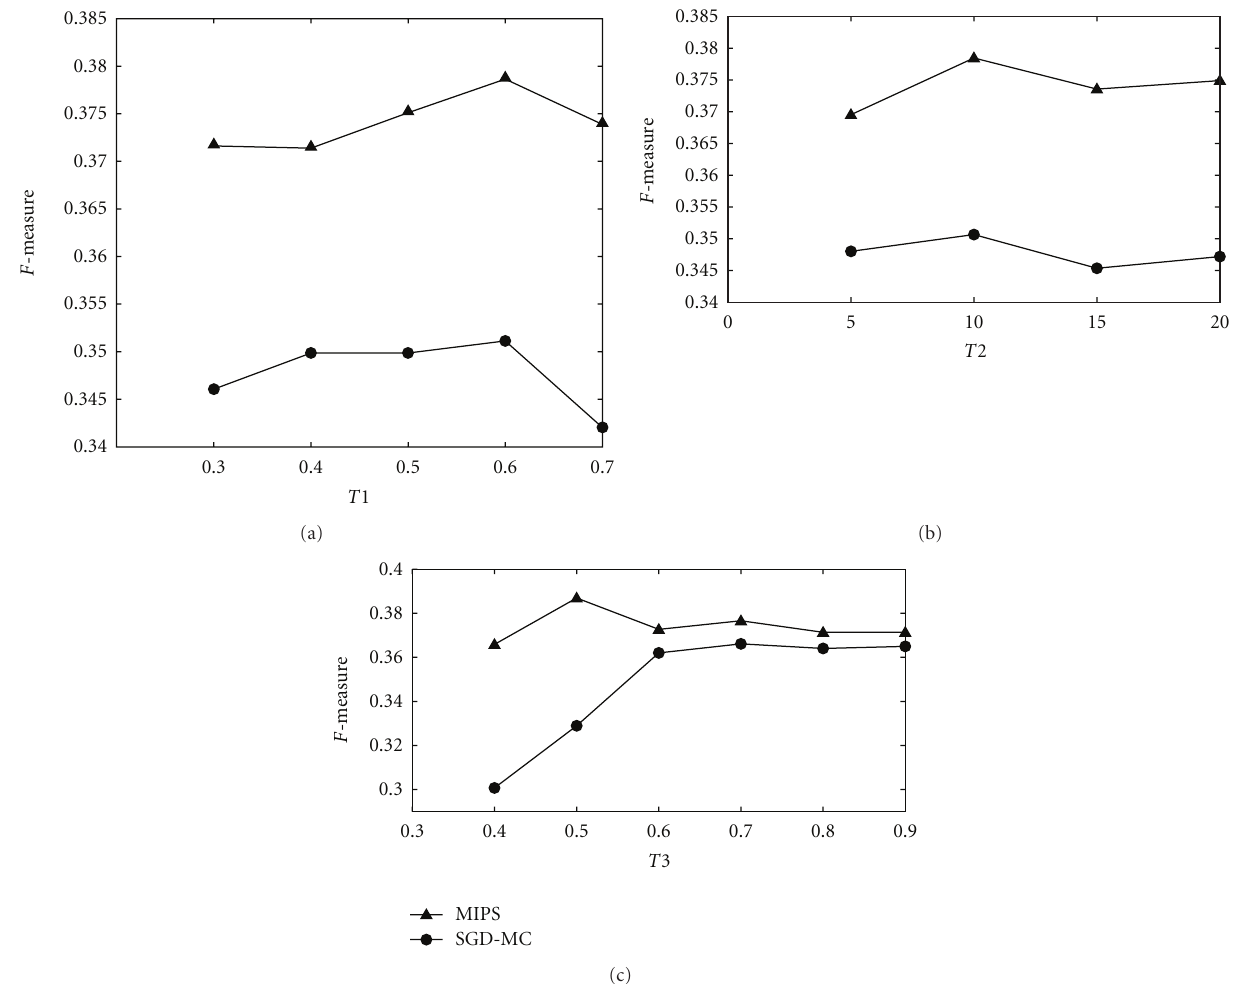
Figure 3: The influence of di ff erent parameters on algorithm performance. Note the F-measure in y -axis is the average value of all F-measures with one parameter specified among the 120 groups of experiment results evaluated by the complexcat benchmark, triangles mark the result on MIPS network, and circles mark the result on SGD-MC network.